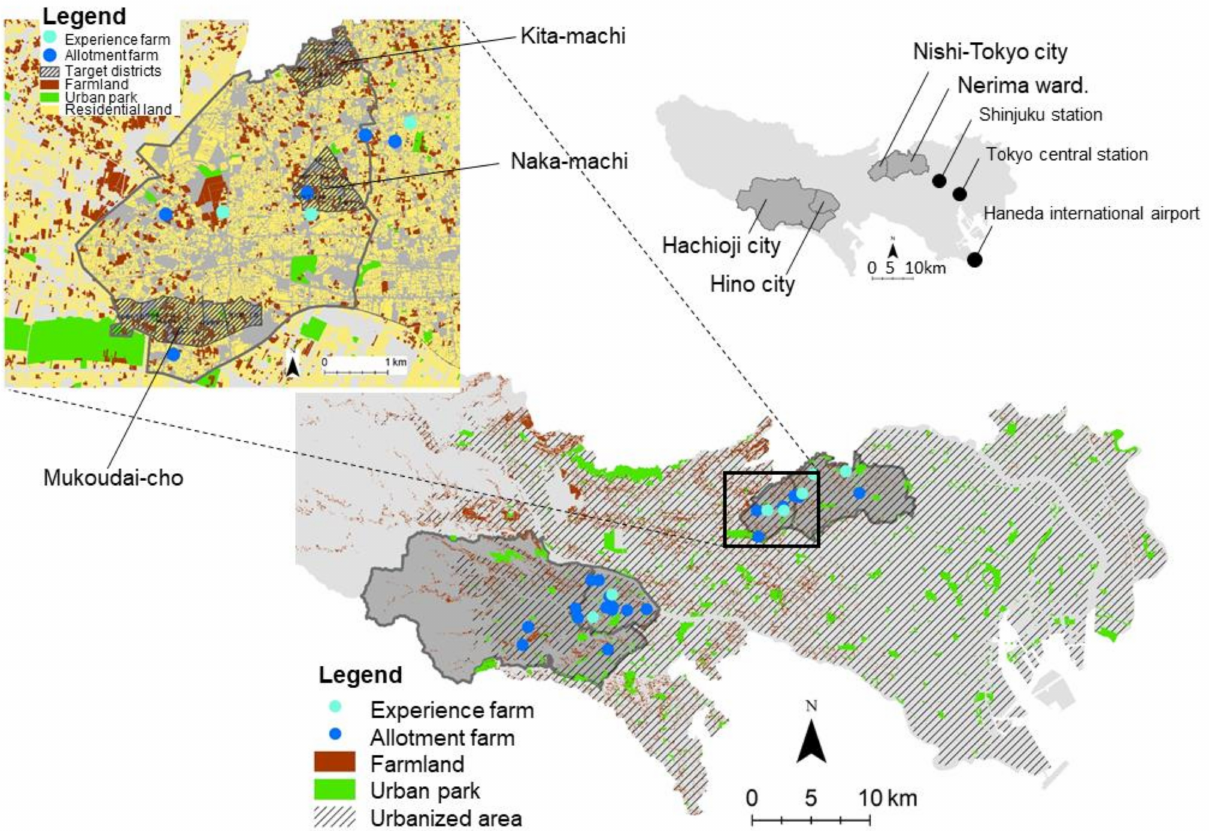
Figure 1. Locations of allotments and experience farms in Tokyo.